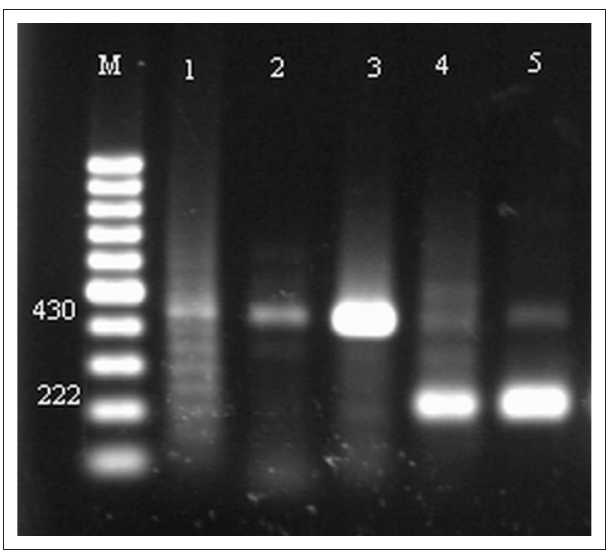
FIGURE 2: Restriction digests of Theileria species amplification products.